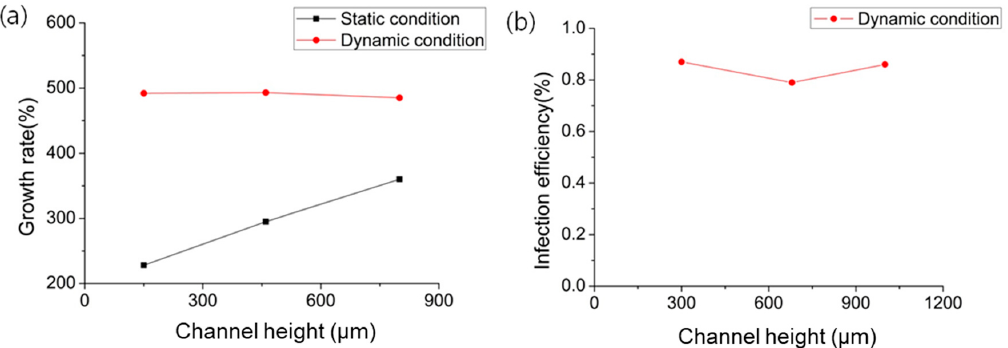
Figure 10. Growth rate of NIH/3T3 cells depending on the microchannel height. Dimensions of the microchannel: 700 μ m (W) × 118 mm (L); flow rate of the dynamic culture: 4 μ L/min.